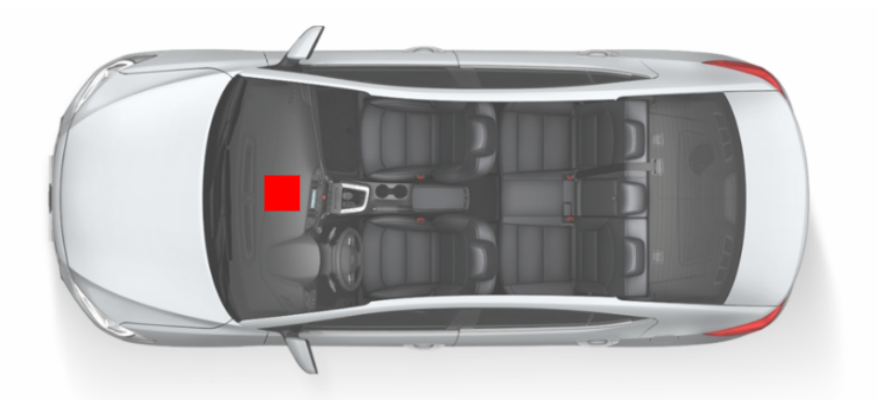
Figure 2. Top view of the car cabin showing the microphone as a red square